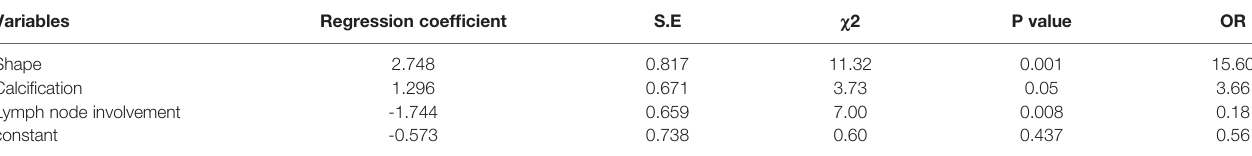
TABLE 2 | Logistic regression model